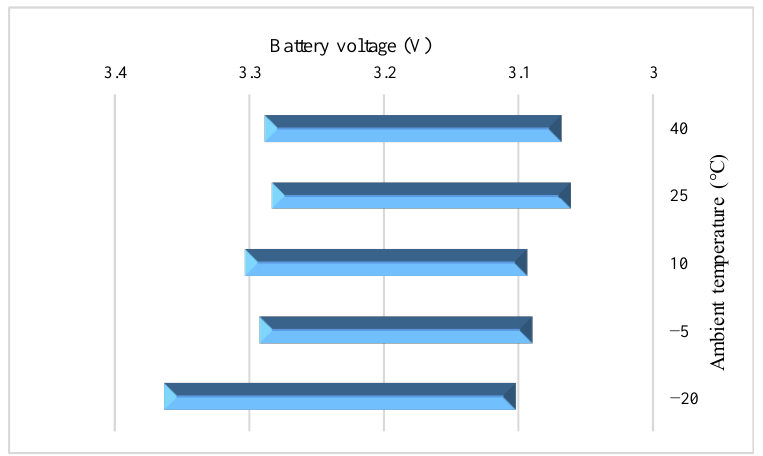
Figure 16. The voltage variation interval diagram of the voltage plateau period during 1C discharge.